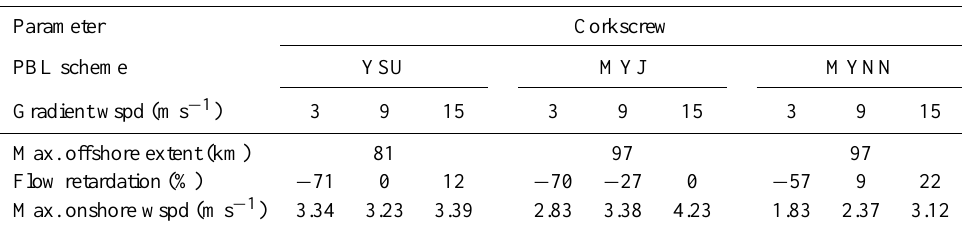
Table 5. Summary of corkscrew sea breeze dual-coast characteristics for varying offshore gradient wind speeds and PBL schemes. The maximum offshore extent is defined as the maximum continuous distance offshore that the u-wind component is less than − 1ms − 1 . The calm zone length is defined as a continuous region with wind speed below 1ms − 1 . The flow retardation percentage is the percentage drop in 10m wind speed over the water surface due to the thermal contrast relative to the average value at 03:00UTC. Negative values represent an increase in 10m wind speed.